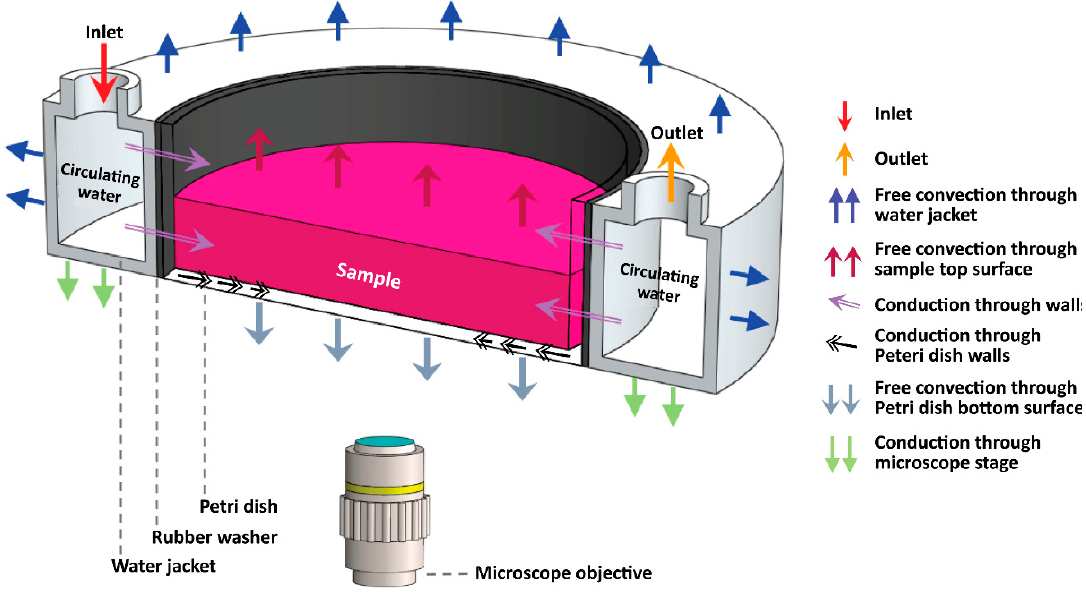
Figure 1. Schematic of the water jacketed system.